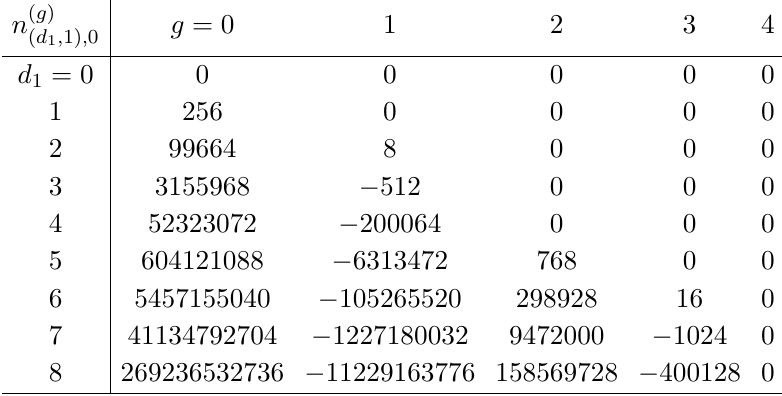
with Z charge 0 2 2